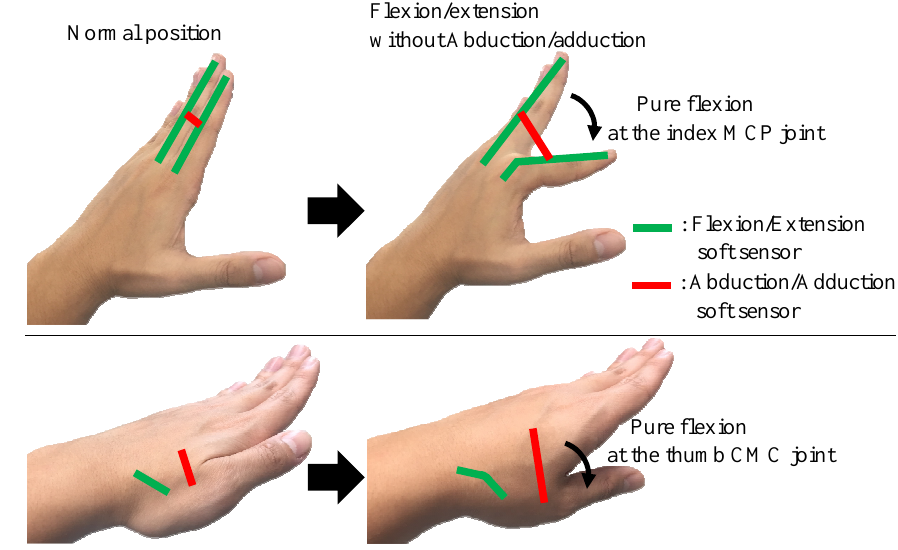
Figure 11. Necessity of algorithms decoupling the soft sensor signals at the CMC and MCP